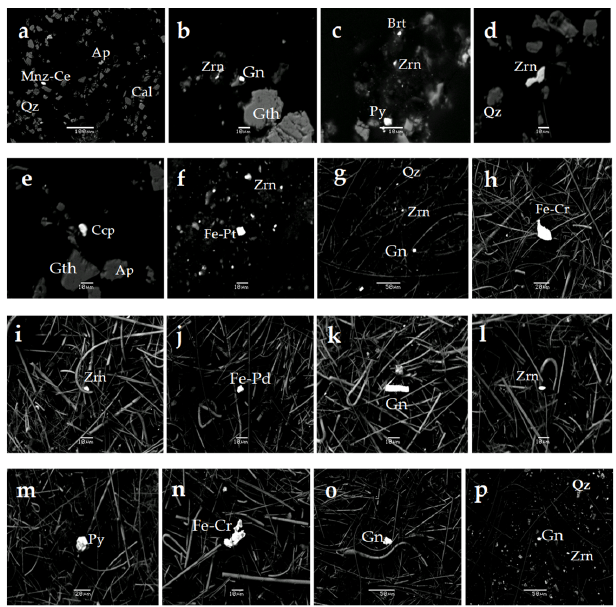
Figure 2. Representative backscattered electron images (BSE) images of road dust ( a – f ) and atmospheric particles ( g – p ) collected from the Katechaki highway peripheral road. There are abundant PM 10 and PM 2.5 particles, with dominant quartz (Qz), calcite (Cal), zircon (Zrn), monazite (Mnz), barite (Brt), galena (Gn), goethite (Gth), metal ‐ Fe (Fe), alloys (Fe ‐ Cr and occasionally Fe ‐ Pt and Fe ‐ Pd), apatite (Ap), pyrite (Py), and chalcopyrite (Ccp). Platinum ranges between 210 and 960 μ g/kg (mean 314 μ g/kg) in dust samples and μ g/kg (mean 536 μ g/kg) in dust samples and from 36 to 1100 μ g/kg (mean 300 μ g/kg) in soils. Dust collected from parts of the roadsides near water sewerages reached as high as 2070 μ g/kg Pt and 1980 μ g/kg Pd in content (Table 1). With the exception of two samples from gully pots showing much higher Pd and Pt contents (Table 1), the calculated total frequency showed that from 51% to 70% of the samples fall in the range from 100 to 300 μ g/kg for Pd and Pt, respectively (Figure 3). The calculated mean accumulation factor is 3.88 for Pd, 2.95 for Pt, and 2.76 for Rh, while any significant difference is lacking ( t ‐ test). The Pt and Pd contents in the samples of dust and soil from Attica are consistent with those from previous studies and other countries [11–17]. The Pd/Pt ratio shows an increas ‐ ing trend of the mean values from the dust (1.4) and soils (1.5) to plants (2.03) (Tables 1 and 2). Despite the different Pt and Pd contents in the dust and soil samples from Athens (a large city with dense traffic) and the smaller Ioannina town [16], with relatively low traffic, their plots show similar positive trends and similar changes in their curve directions (Fig ‐ ure 4). Various plant species grown on potentially contaminated roadside soil were col ‐ lected, corresponding to soil samples from their rhizosphere (Table 2), in order to assess the bioaccumulation of Pt, Pd, and Rh. The background values used for soils and plants from Attica were those reported by the GEMAS (Geochemical Mapping of Agricultural and grazing land Soil) [18].